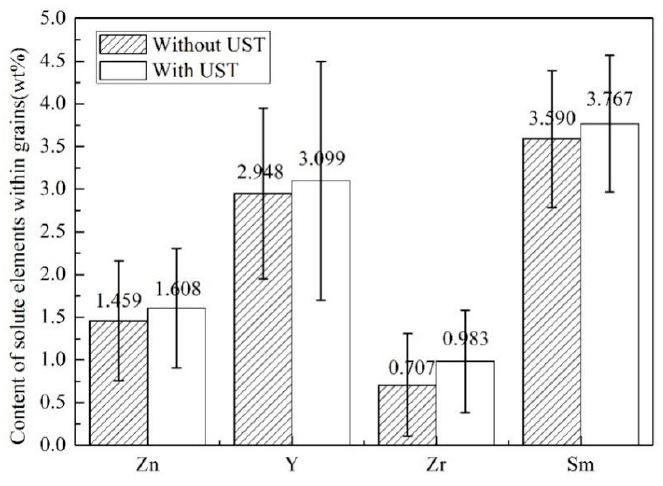
Figure 7. Content of solute elements within grains.